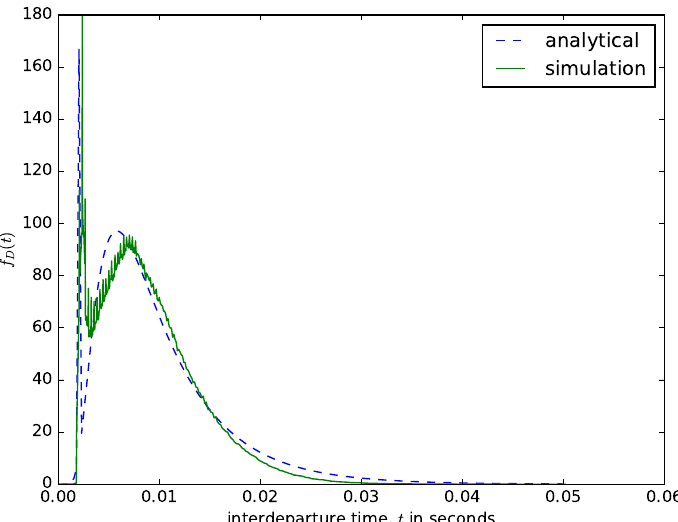
Figure 11. The distribution of the interdeparture times for a size-based packet aggregation